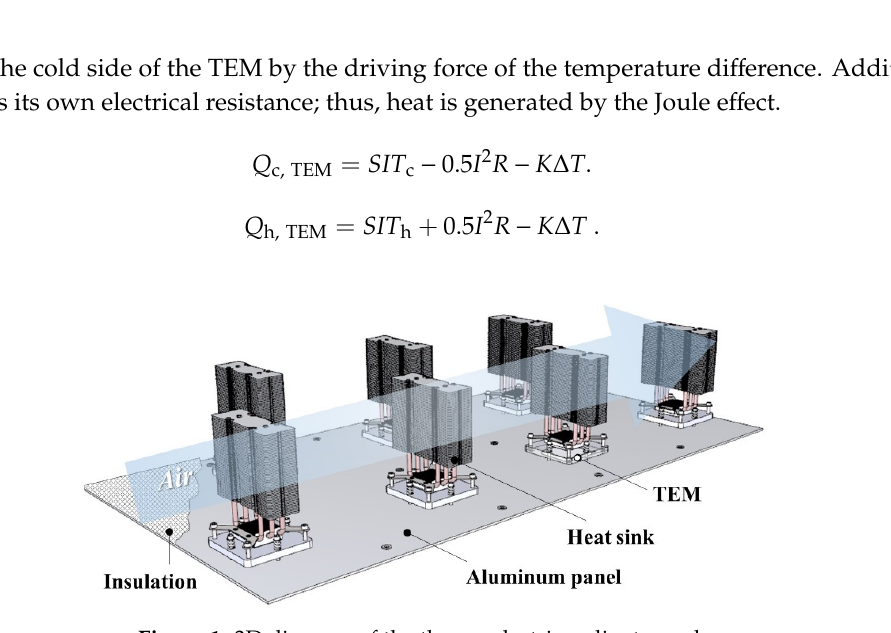
Figure 1. 3D diagram of the thermoelectric radiant panel.